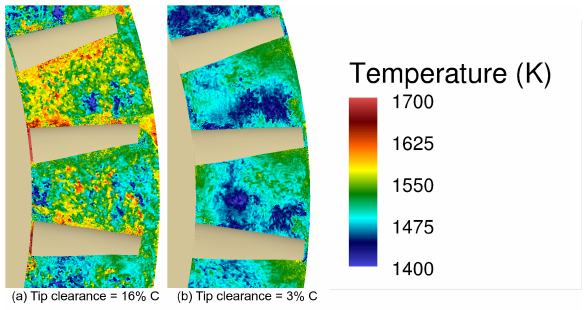
Figure 16. Instantaneous temperature contours on the plane normal to the axial direction at the location z = 0 passing through the middle of the rotor section at 75% rotor RPM for: ( a ) 16% chord tip clearance; and ( b ) 3% chord tip